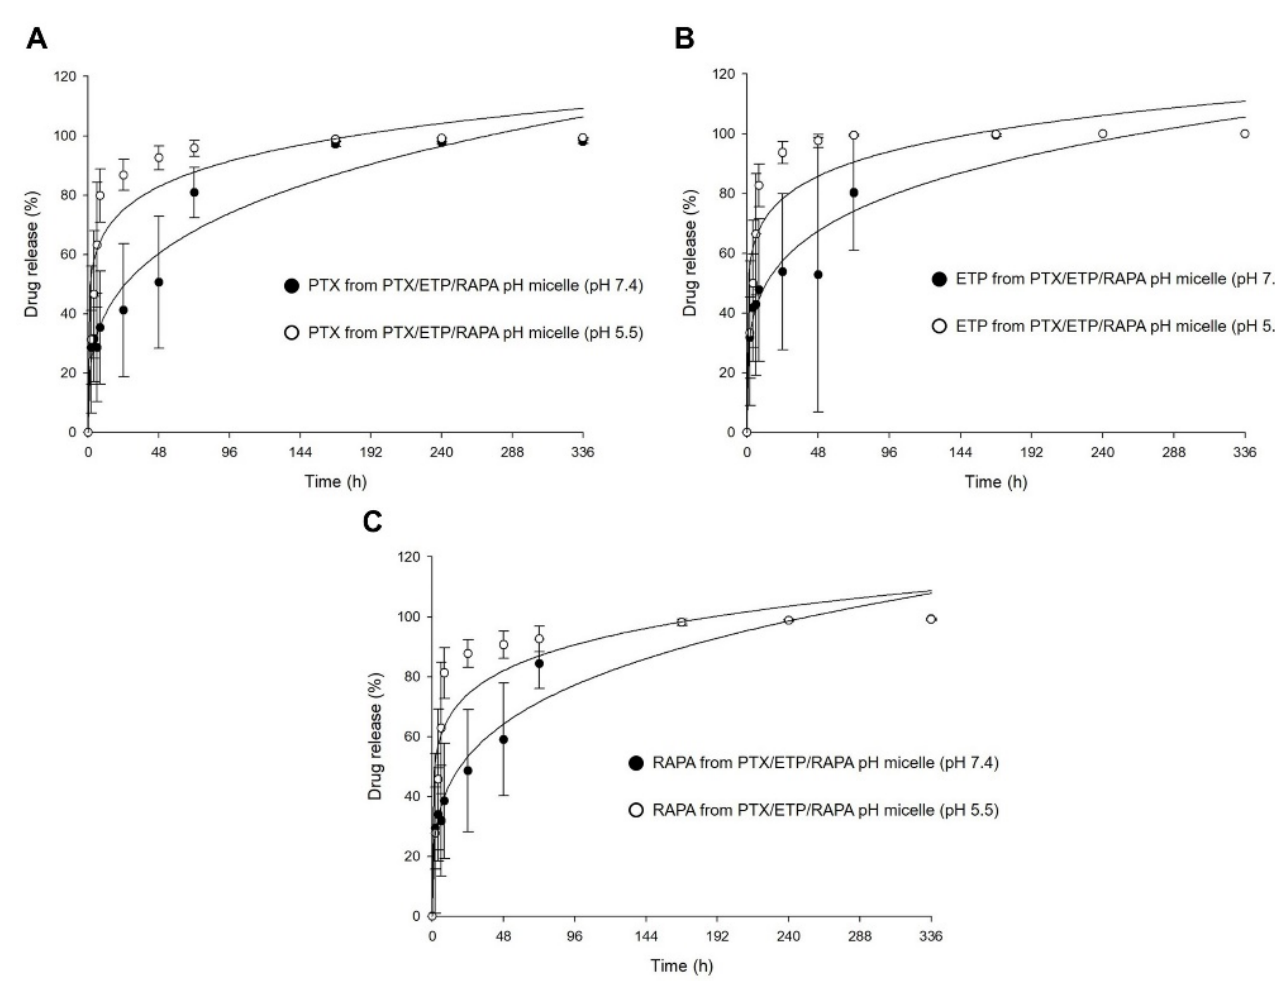
Figure 5. In vitro release profiles at different pH values of ( A ) PTX, ( B ) ETP, and ( C ) RAPA release in PTX/ETP/RAPA-loaded mPEG-pH-PCL micelles (n = 3–4).